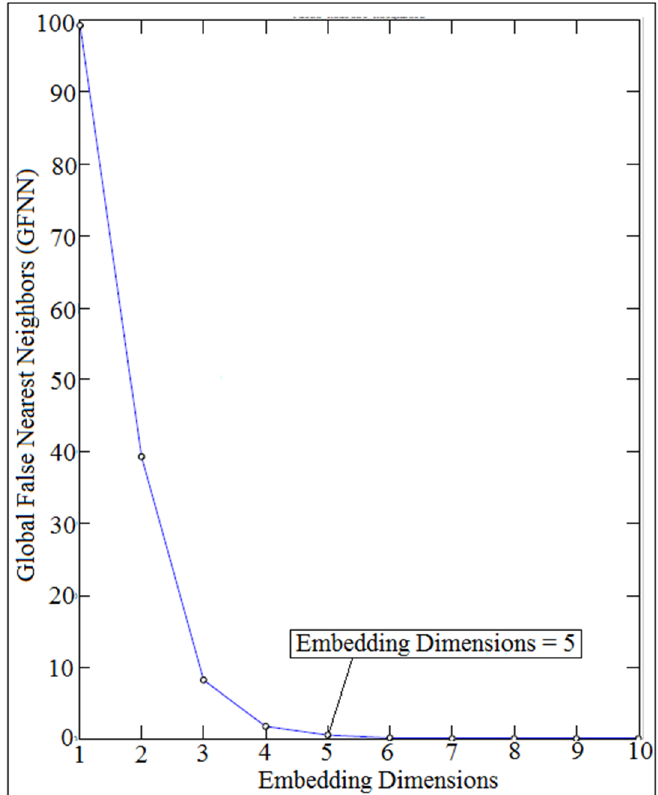
Figure 21. Embedding dimensions of numerical simulation.